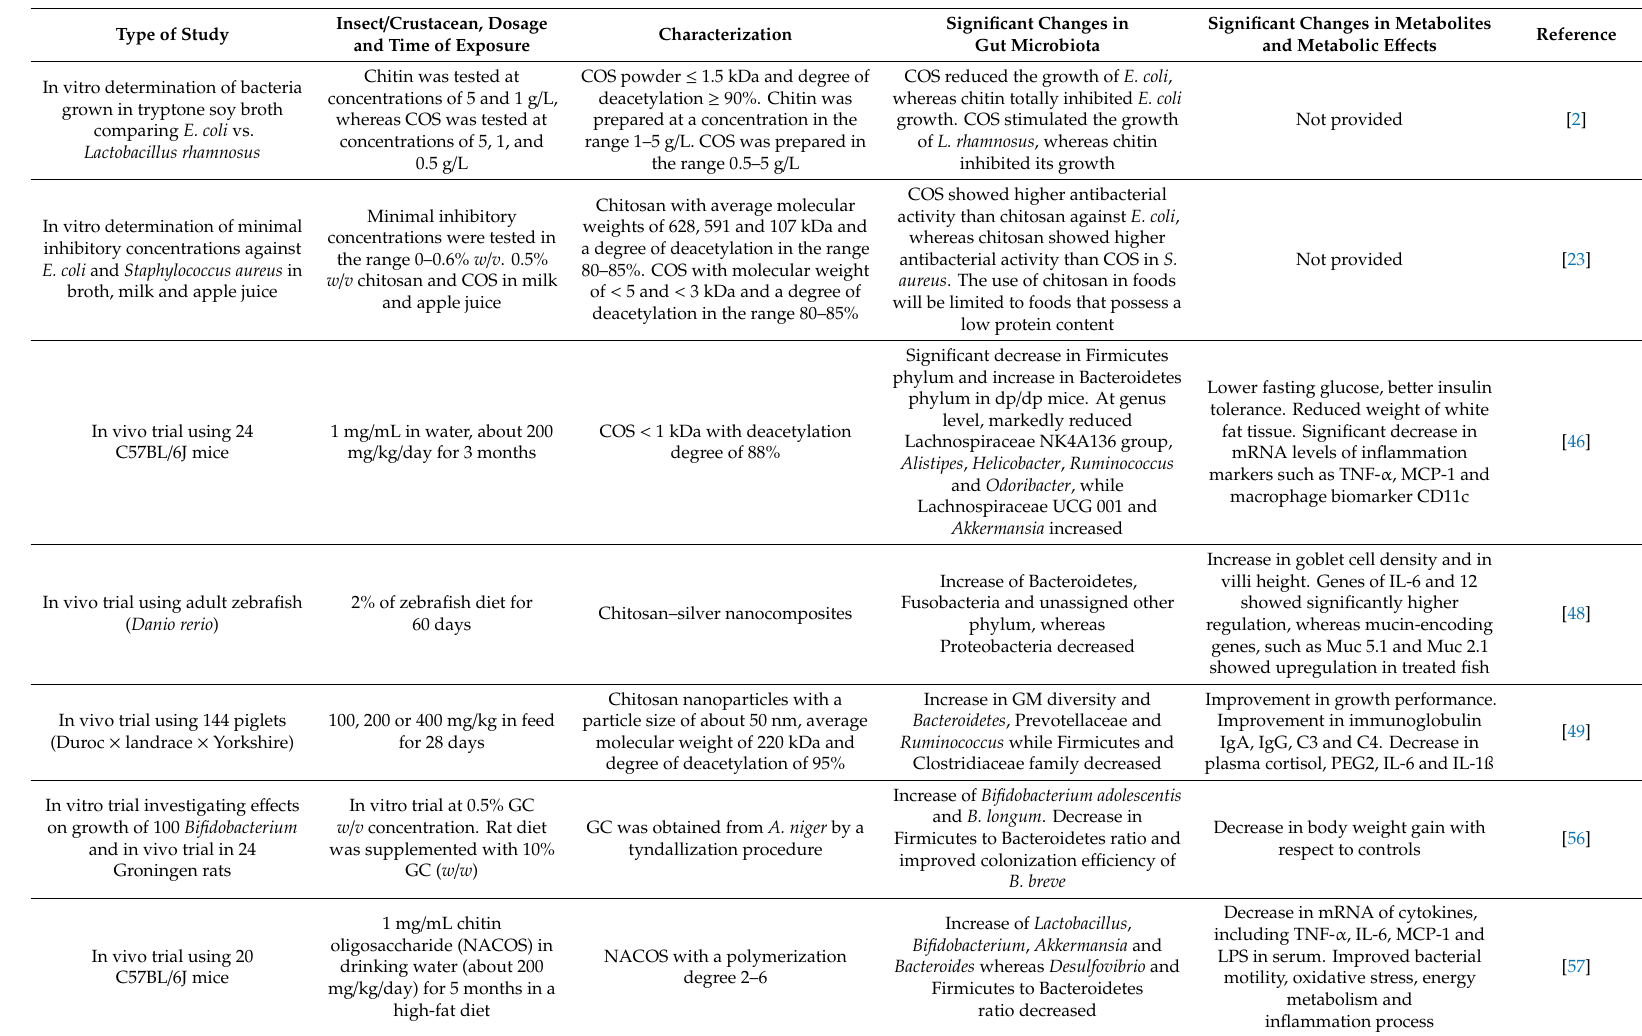
Table 2. E ff ect of chitin derivatives on the gut microbiota di ff erent